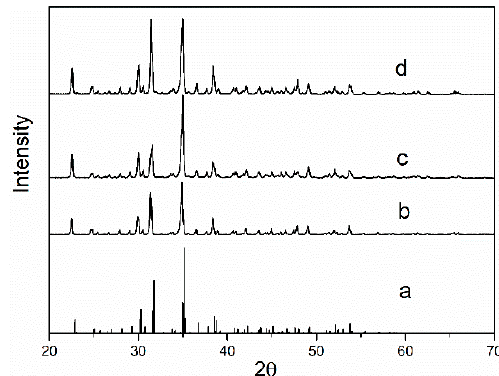
Figure 2. X-ray diffraction (XRD) pattern of sodium tetraborate decahydrate ( a ) standard; ( b ) crystalized in pure water; ( c ) crystalized Na 2 CO 3 -NaCl-Na 2 B 4 O 7 -H 2 O systems; ( d ) crystalized Na 2 CO 3 -NaCl-Na 2 SO 4 -Na 2 B 4 O 7 -H 2 O systems.